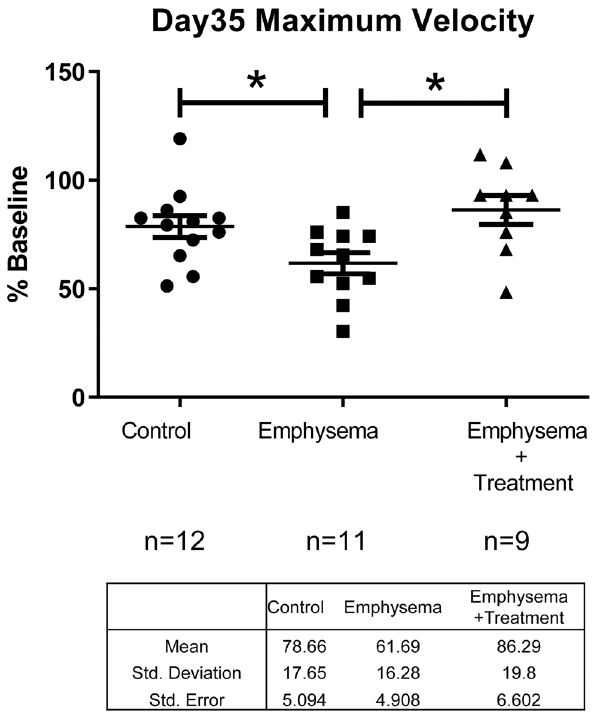
Figure 4. Maximum velocity on day 35. While the emphysema group showed a significant reduction in peak exercise velocity compared to that in the control group, the treatment group showed significantly improved peak exercise velocity compared with emphysema group that represents the therapeutic effect of the RF therapy. Asterisks above the horizontal lines indicate a significant difference in the comparisons between the groups (*p < 0.05).